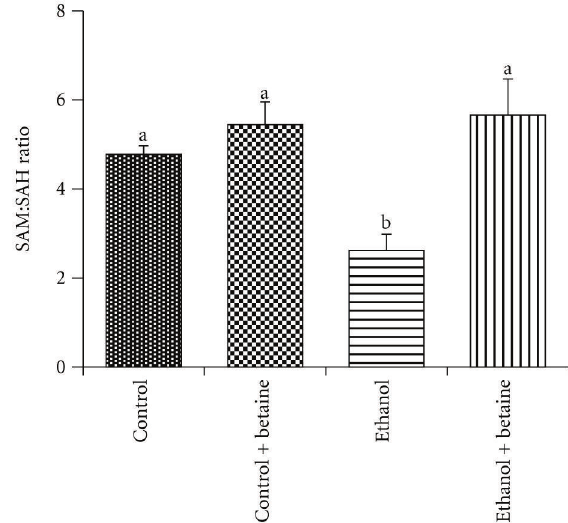
Figure 2: Betaine attenuates chronic ethanol-mediated increase in hepatic triglyceride levels. Triglyceride content in the liver lipid extract was quantified using the diagnostics kit (Thermo Electron Clinical Chemistry, Louisville, Colo, USA). Data represent the mean ± S.E.M. for n = 8 animals per treatment group. Values not sharing a common letter are statistically di ff erent, P < 0 . 05.